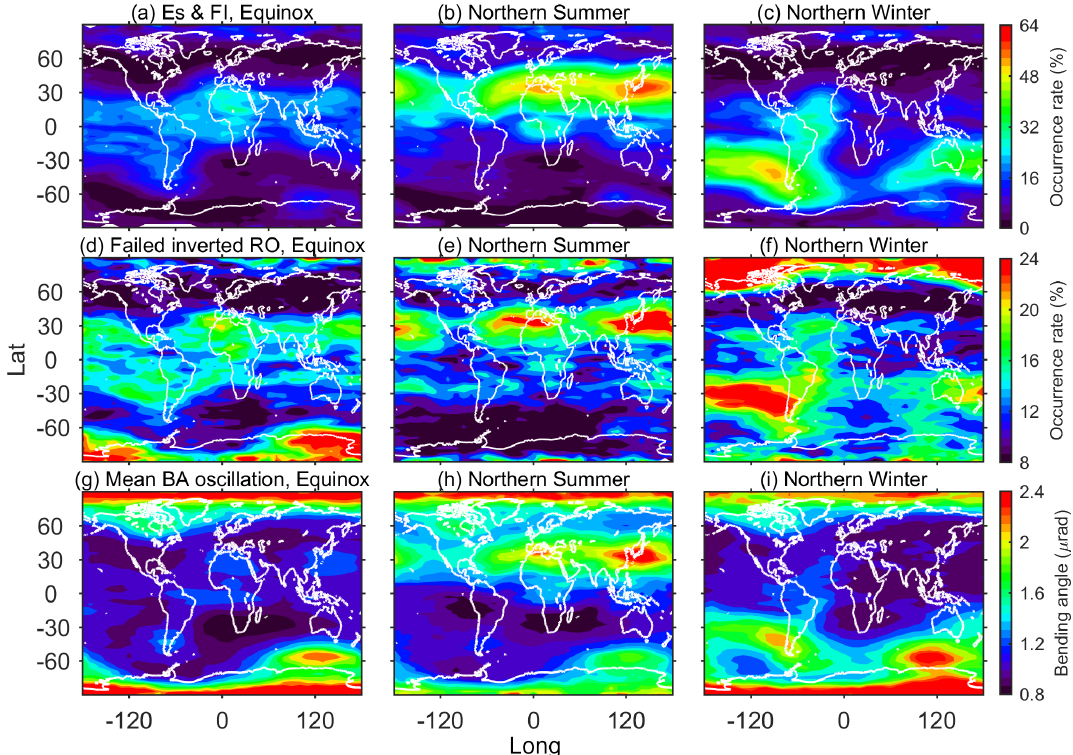
Figure 6. Global geographical distribution of the E s and F layer irregularity occurrence rate (a–c) , the failed inverted RO occurrence rate (d–f) , and the mean bending angle oscillation (g–i) for equinox (a, d, g) , northern summer (b, e, h) , and northern winter (c, f, i)